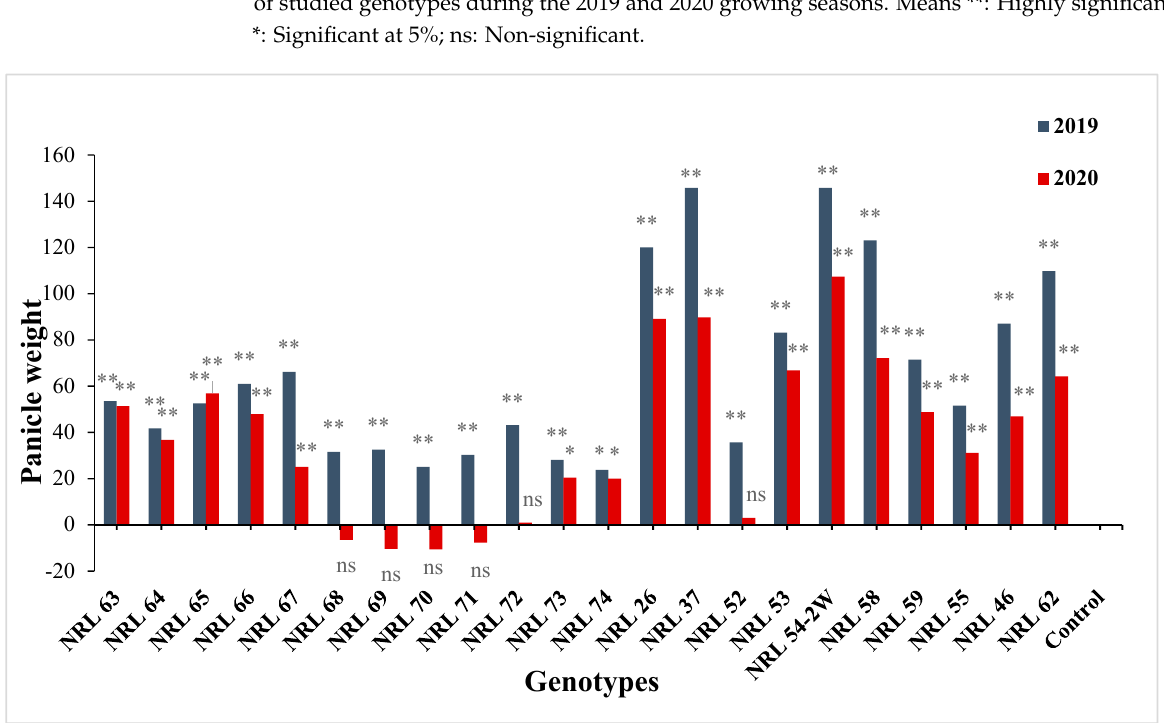
Figure 8. The percentage of advantage over commercial variety for panicle weight of studied genotypes during the 2019 and 2020 growing seasons. Means **: Highly significant at 1%; *: Significant at 5%; ns: Non-significant.